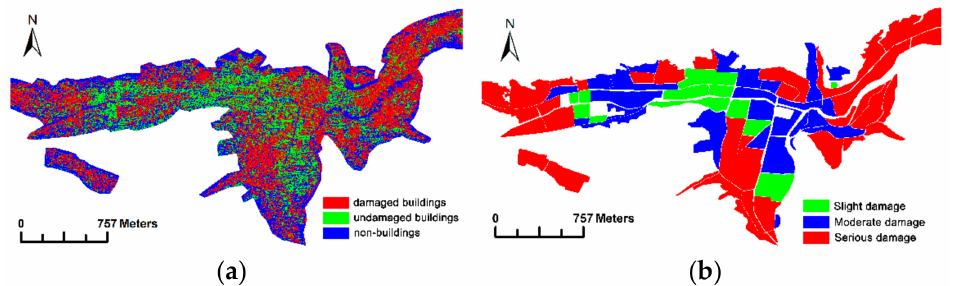
Figure 11. The experiment results of IYFD method for Yushu urban region. ( a ) Extraction results for the damaged buildings, undamaged buildings, and non-buildings; ( b ) building earthquake damage assessment results at the city block